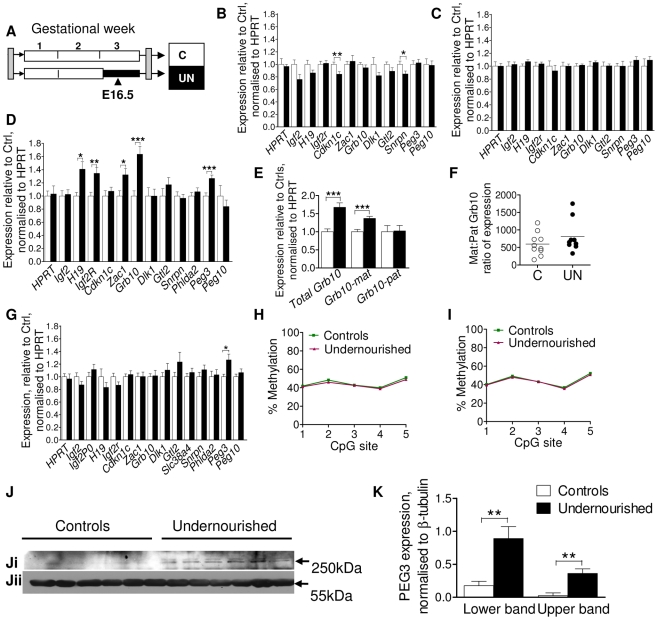
Assessment of candidate imprinted genes at E16.5 in the F1 generation.(A) Schematic of the F1 generation, imprinted gene expression was assessed at E16.5, the mid-point of maternal caloric restriction. (B–G) Imprinted gene expression assayed by qPCR, normalised to HPRT and expressed relative to controls: Open bars/circles represent controls, black bars/circles, undernourished individuals. Error bars show SEM. (B) Brain. Per condition n = 12, 3 litters. Unpaired two-tailed t-test Cdkn1c P = 0.009, Snrpn P = 0.036. (C) Muscle (tongue): per condition n = 12, 3 litters. (D) Liver: per condition n = 36, 5 litters H19 P = 0.02, Igf2r P = 0.008, Zac1 P = 0.02, Grb10 P = 0.0002, Peg3 P = 0.005. (E) The increased hepatic expression of Grb10 in F1 E16.5 liver is of the appropriate maternal-type isoforms (mGrb10α and mGrb10δ). Per condition n = 36, 5 litters Grb10 P = 0.0002; matGrb10 P<0.0001. (F) In the few individuals where some expression of paternal-type isoforms (mGrb10β1 and mGrb10β2) is detectable in E16.5 liver, this expression is dwarfed by that of maternal-type isoforms. (G) Placenta: per condition n = 24, 5 litters. Peg3 P = 0.017. (H, I) Methylation at the Peg3 promoter DMR assessed by pyrosequencing. Data presented are the average of three independent bisulphite treatments. Per condition n = 12, 3 litters, error bars show SEM. In utero undernutrition does not affect the methylation status of the Peg3 promoter DMR in (H) F1 E16.5 brain (I) F1 E16.5 liver. (J) Western blot of PEG3 (Ji) and β-tubulin (Jii) using brain tissue of E16.5 control and undernourished foetuses. Per condition n = 6, 3 litters. (K) Although Peg3 mRNA is unaffected (Figure 3B), expression of PEG3 is increased relative to β-tubulin in the brain of undernourished E16.5 foetuses. Data represent the average of two technical replicates. Error bars denote SEM.